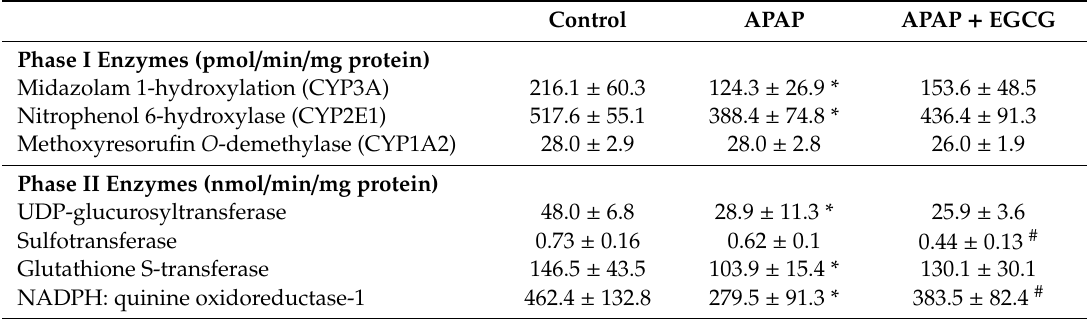
Table 3. Drug-metabolizing enzyme activities in the rat liver after APAP challenge for 12 h a .